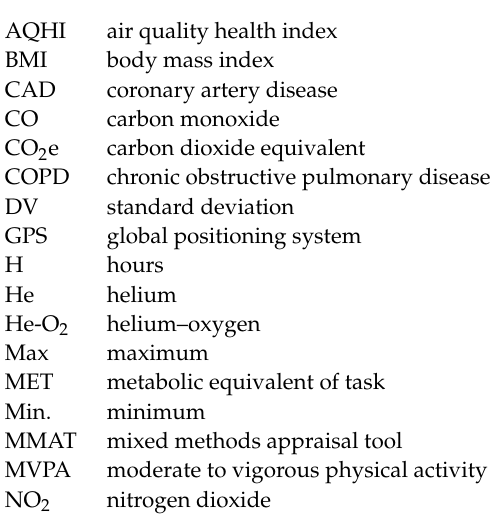
Protocol. Table S2: Literature search strategy on PubMed. Table S3: Titles of included reviews